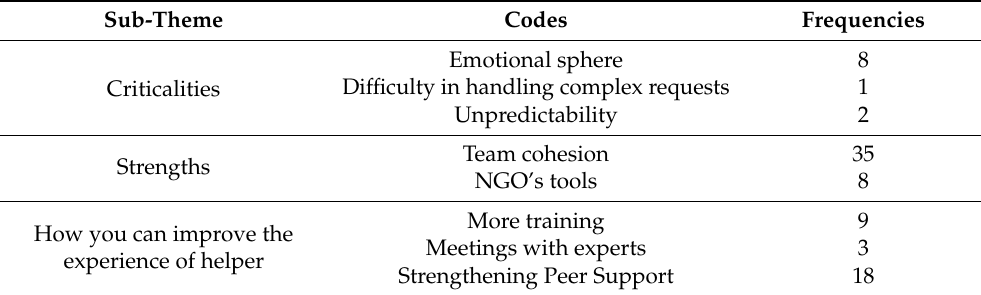
Table 6. Theme 4: “Criticalities and strengths”, sub-themes, codes that emerged and related frequencies.